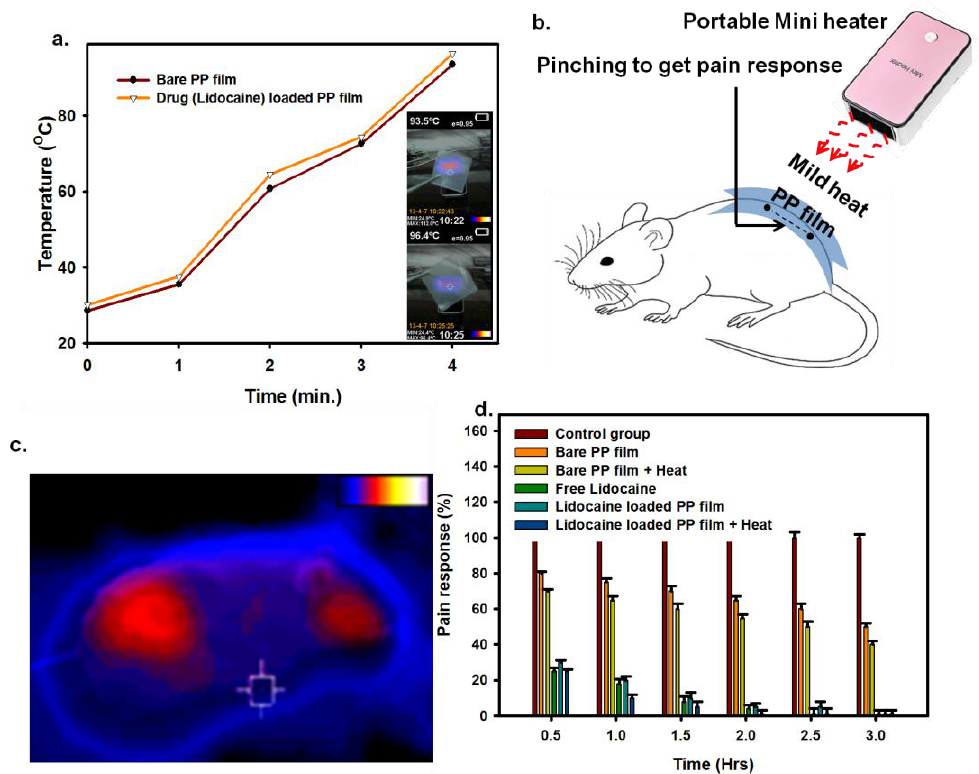
Figure 3. ( a ) Time-dependent heat generation curve of bare PP film and drug-loaded PP film as a function of external mini-heater. The inset images show the portable mini-heater (50 W)-induced thermographic image of bare PP film and drug-loaded PP film after 4 min of continuous observation. ( b ) Schematic image of pinching test model on mice. ( c ) Thermo-graphic image used to monitor temperature on mouse skin treated with drug-loaded PP film using a portable mini-heater to maintain a constant temperature of 45 °C. ( d ) Percentage (%) pain response in mice treated with bare PP film, bare PP film with heat, free lidocaine, lidocaine-loaded PP film, and lidocaine-loaded PP film with heat. Mild heat was induced by an external mini-heater (50 W) for 5 min to maintain a constant temperature of 45 °C. The pinching tests for pain response were evaluated 0.5 to 3.0 h after 5 min treatment at 45 °C.